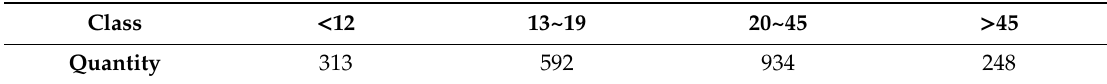
Table 1. Age ranges in the CIA